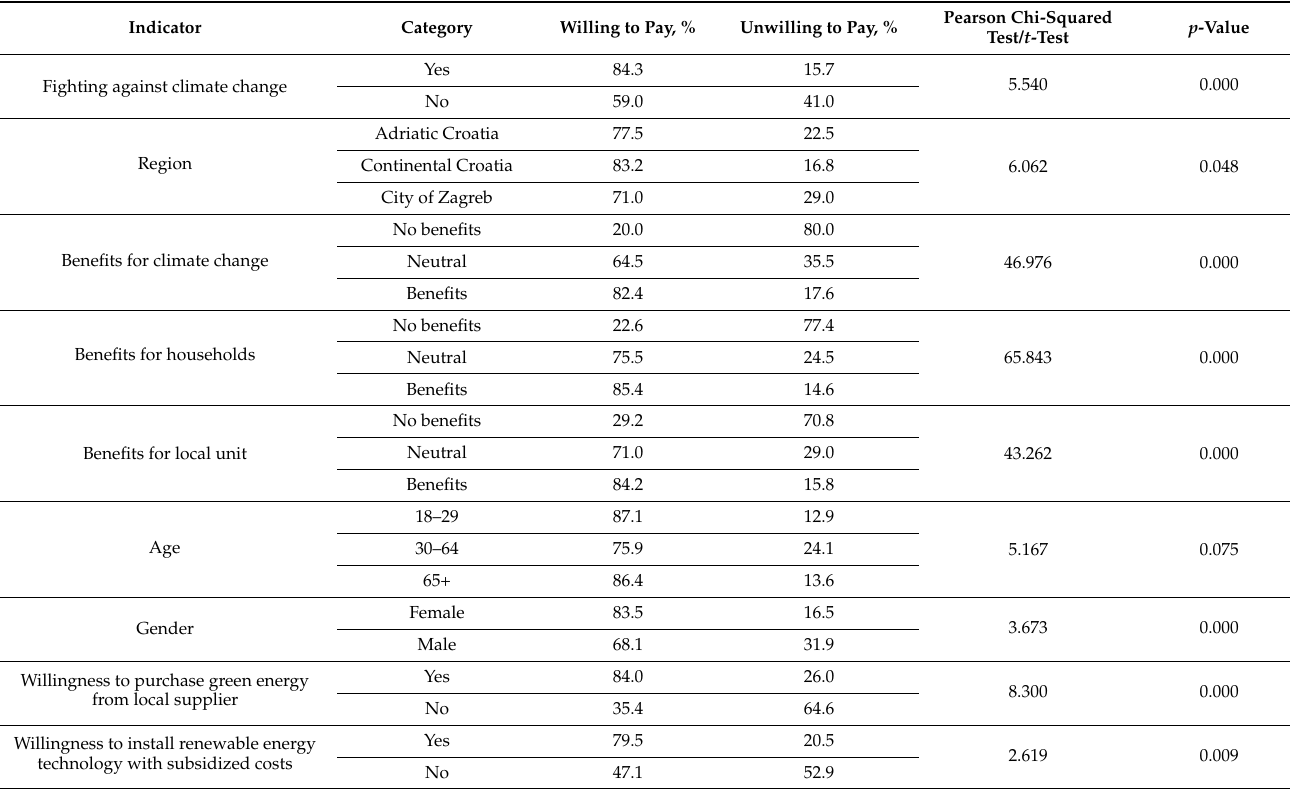
Figure 6. Willingness to pay for renewable energy technology in household per month. Note: amounts are recalculated from HRK to EUR according to Croatian National Bank exchange rate for 2020: 1 EUR = 7.53308 HRK. Source: Authors’ research. Table 4. Willingness to pay for the use of renewable